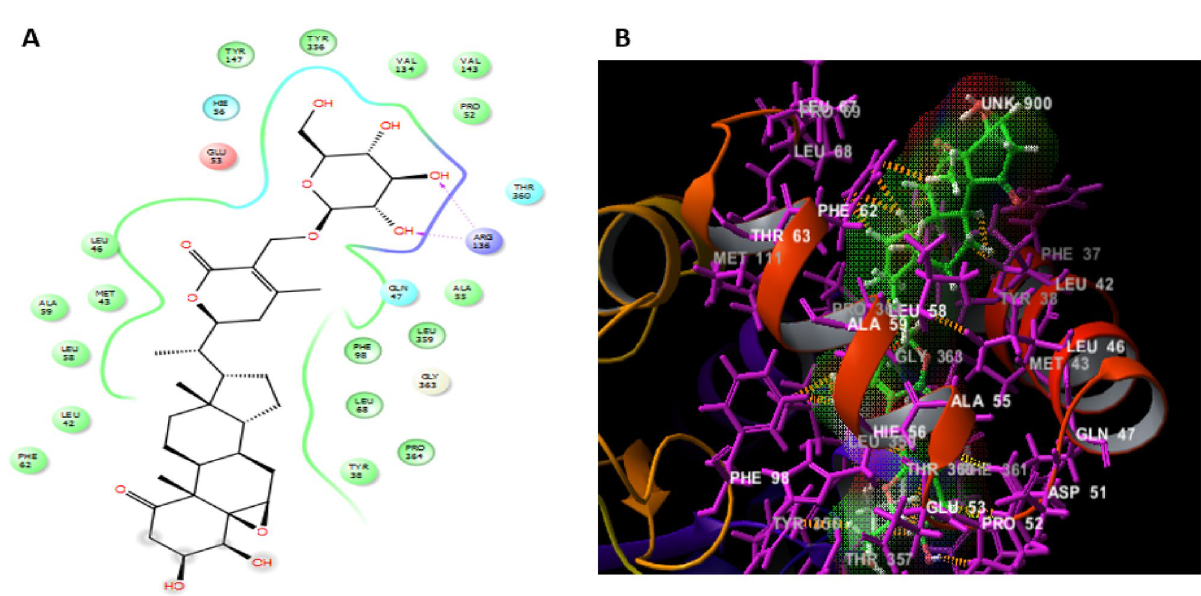
Figure 6. The docked pose of 27- O-β- D-glucopyranosyl viscosalactone B interacting with the amino acid residues of hDHODH active site in 2D ( A ) and 3D ( B )